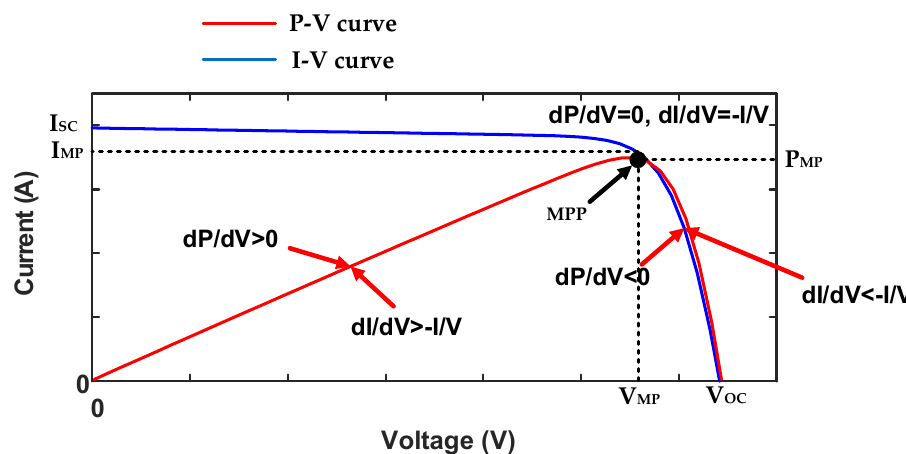
Figure 9. P-V curve of the PV system and signs of its slope at various Figure 9. P ‐ V curve of the PV system and signs of its slope at various regions. Table 3. INC algorithm.